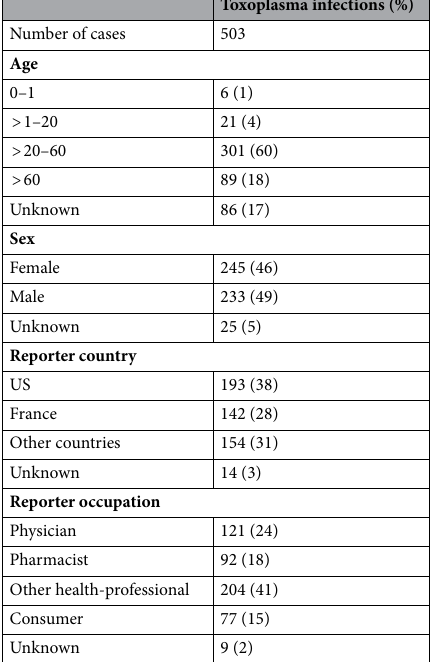
Table 1. Baseline information.